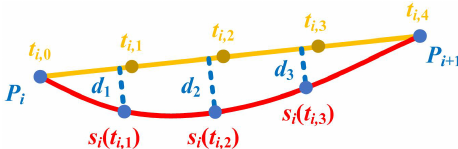
Figure 3. Contour error of the i th segment.